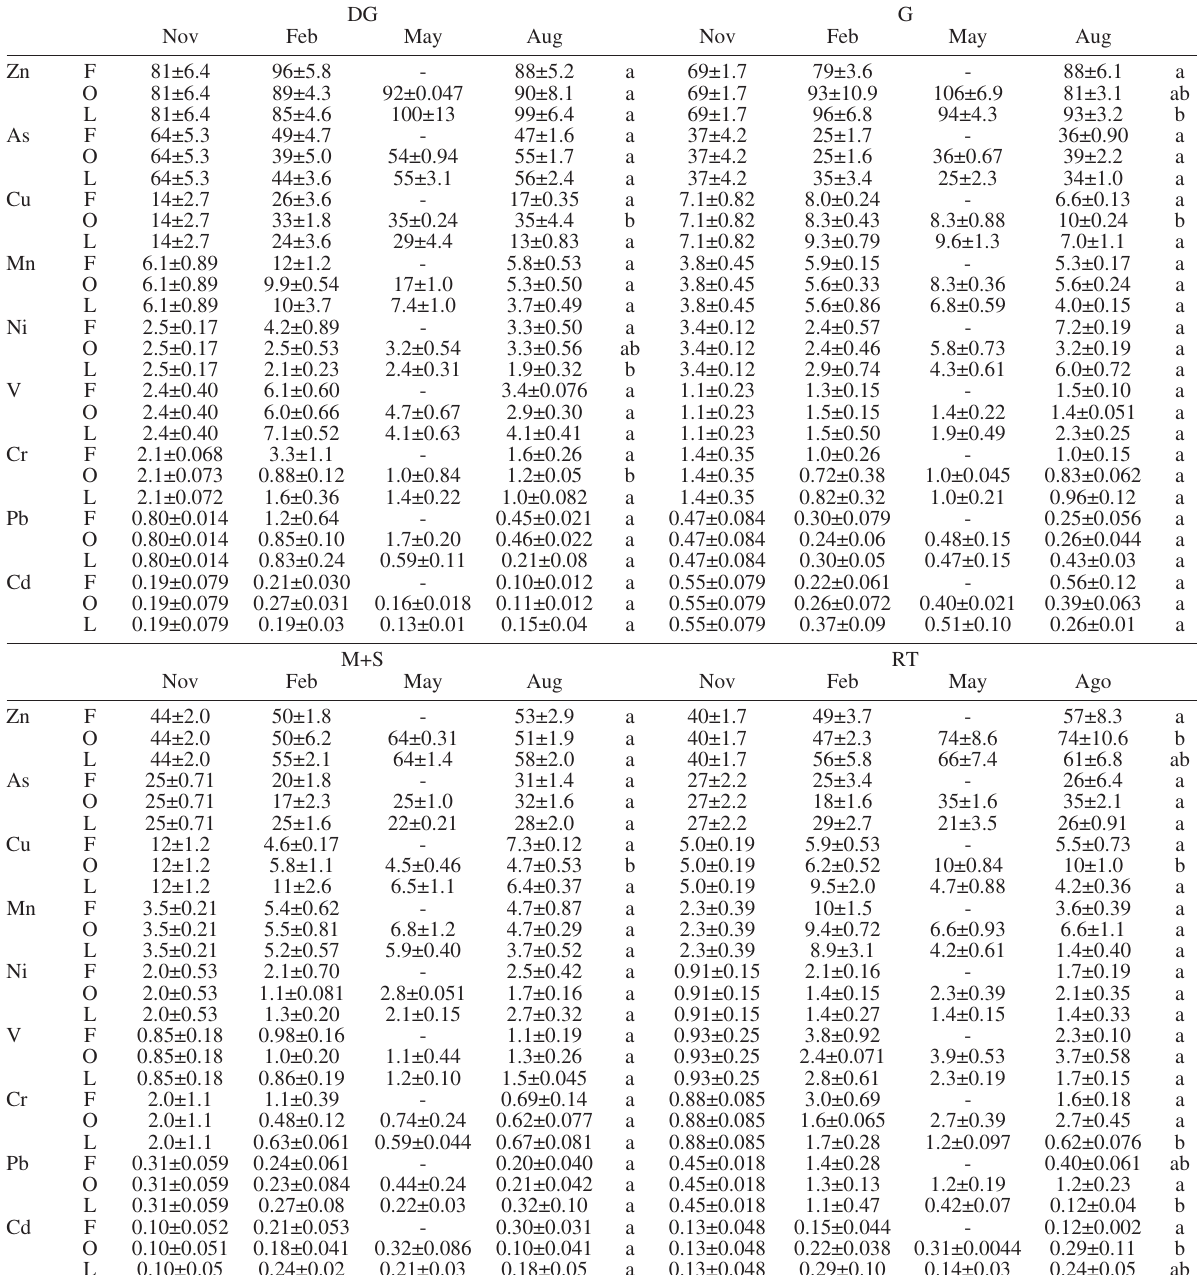
Table 4. – Concentrations (μg g –1 dw) of Zn, As, Cu, Mn, Ni, V, Cr, Pb and Cd in digestive gland (DG), gills (G), mantle plus siphons (M+S) and remaining tissues (RT) of clams Ruditapes decussatus collected at sites F, O and L in November, February, May and August 2011; mean ± SD (n=3); different letters (a, b, c) correspond to significant (p<0.05) differences among sites, considering all sampling dates.